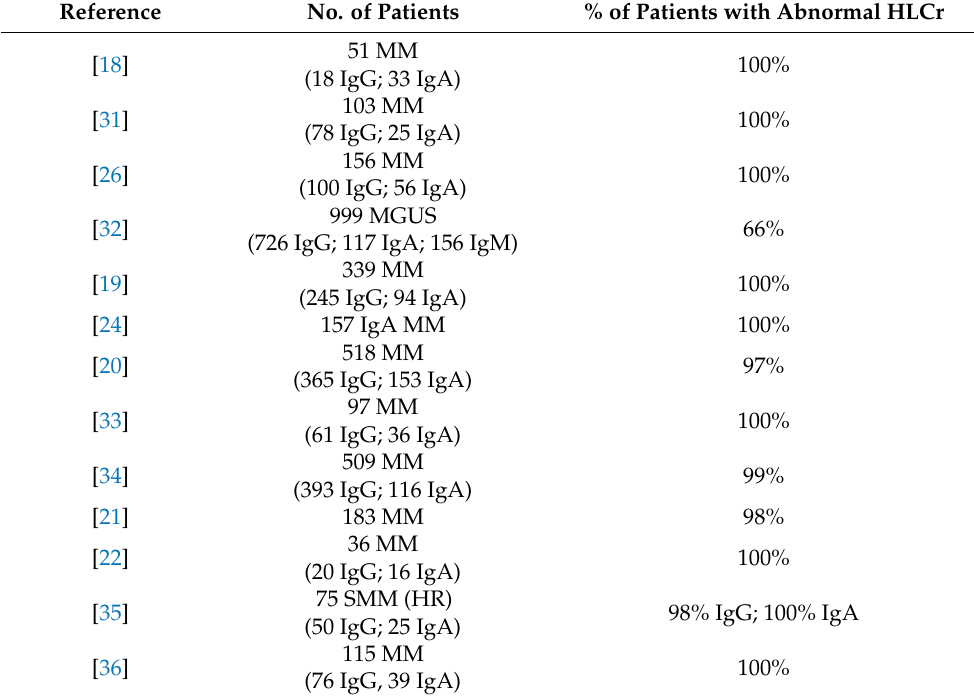
Table 4. Heavy/light chain ratio (HLCr) sensitivity displayed at diagnosis in different